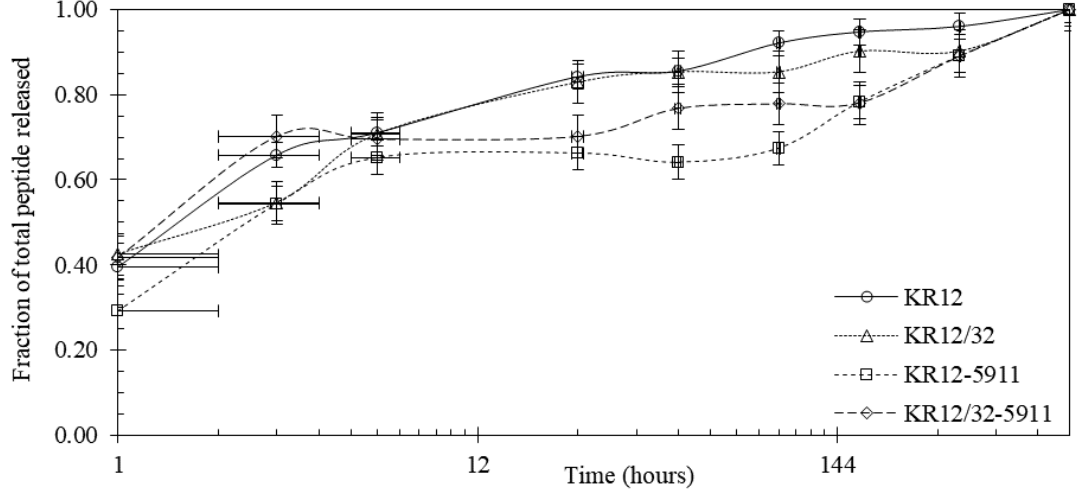
Figure 6. Release profile showing the percentage of the total peptides released in SBF from the